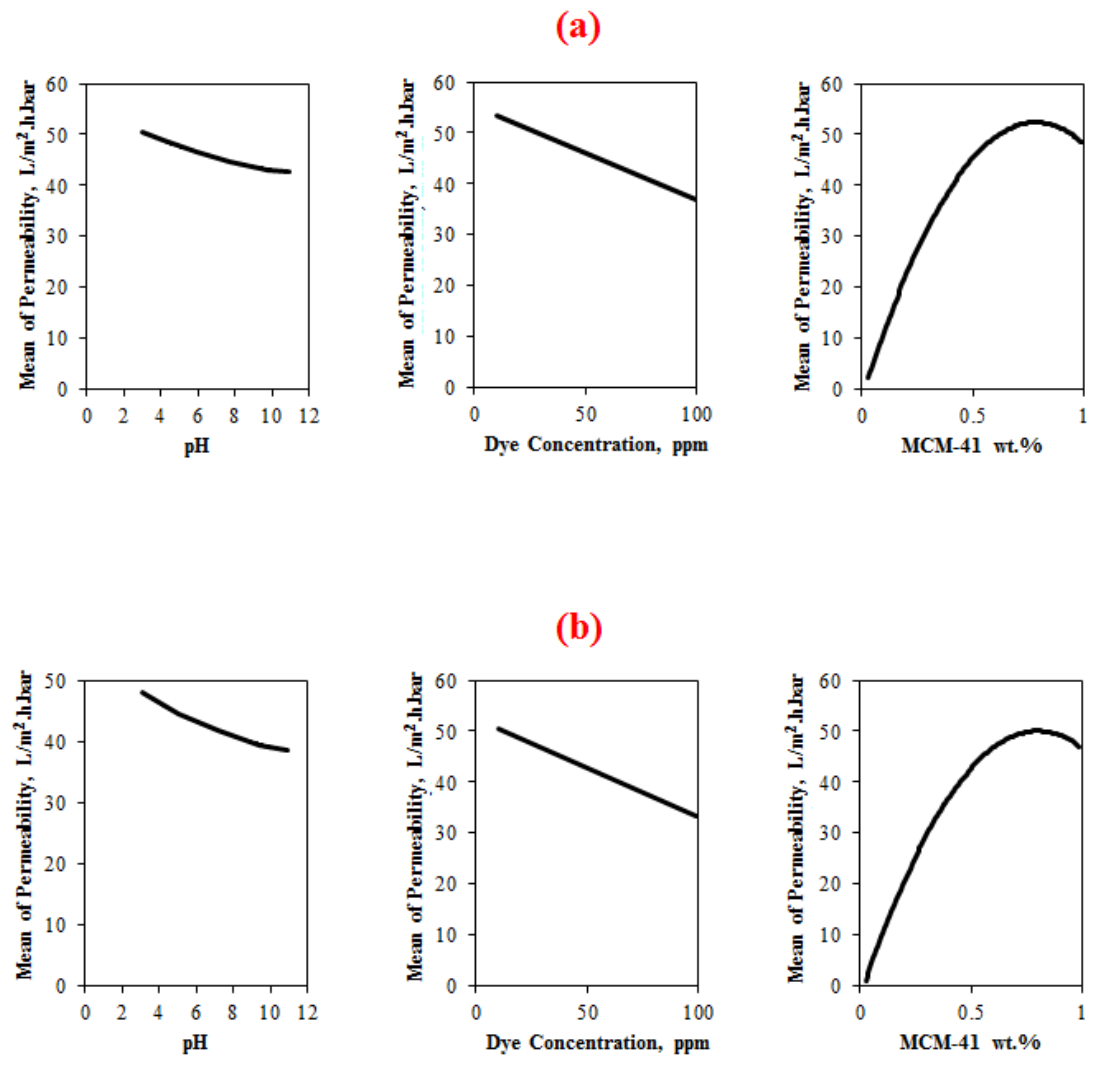
Figure 2. Main effect plot of the pH, concentration, and MCM-41 wt.% on the permeability of ( a ) AB—210, and ( b ) RB dyes.